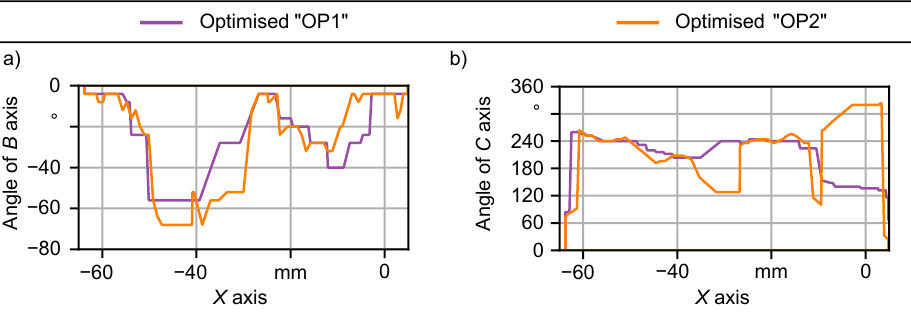
Figure 13. Resulting simulated mean Poincaré diameter of optimised NC paths with various parame- ters using ( a ) the average PD and ( b ) the max PD as stability criteria.